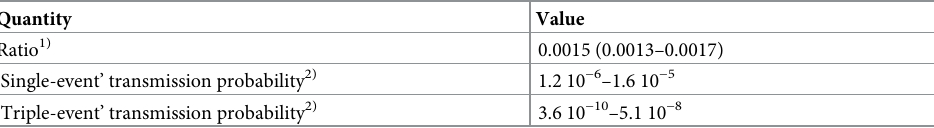
Table 2. The risk of HPAI transmission jumps from one area to another, due to a compartment with only egg transports (i.e. no animal transports), and with no compartment farms situated in a DPPA. Quantity